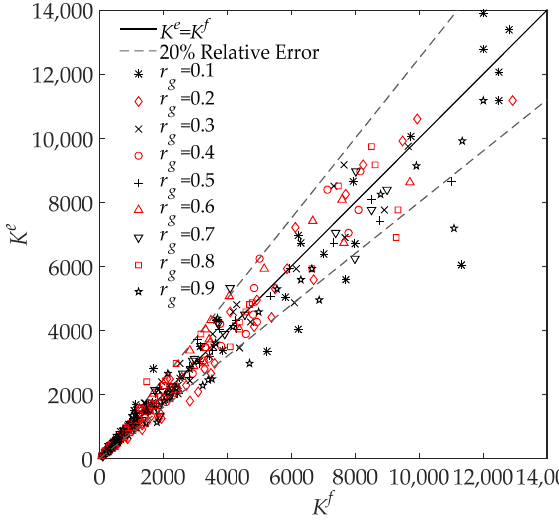
Figure 8. FEM-simulated K f and analytical K e under all 405 air gap settings. If the FEM result is the same as the analytical result, the point should fall on the black perfect line K e = K f .